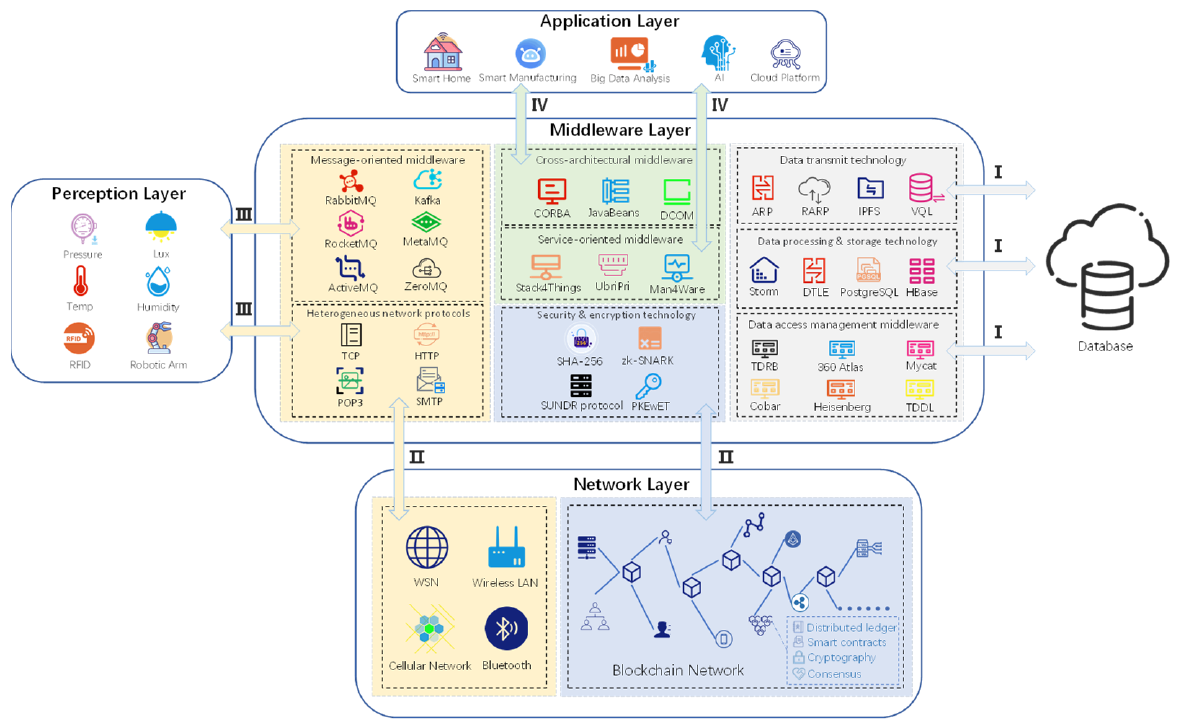
Figure 4. The architecture of the blockchain middleware for decentralized IIoT. Table 3. Related work on four processes in the architecture of blockchain middleware.